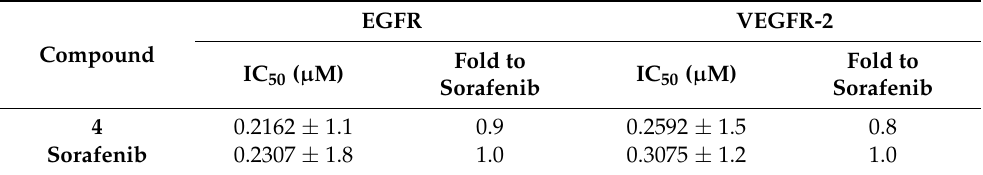
Table 2. EGFR and VEGFR-2 inhibitory activities of compound 4 with their fold inactivation relative to the Sorafenib.